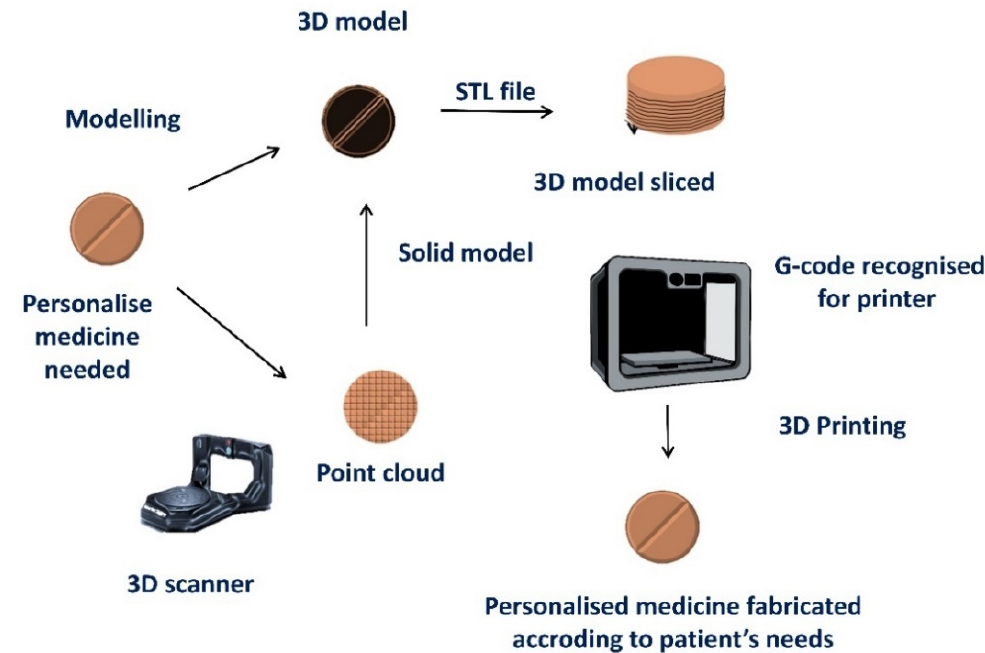
Figure 2. Schematic depicting the steps required for 3D printing of personalized medicines. Modified from: [19].